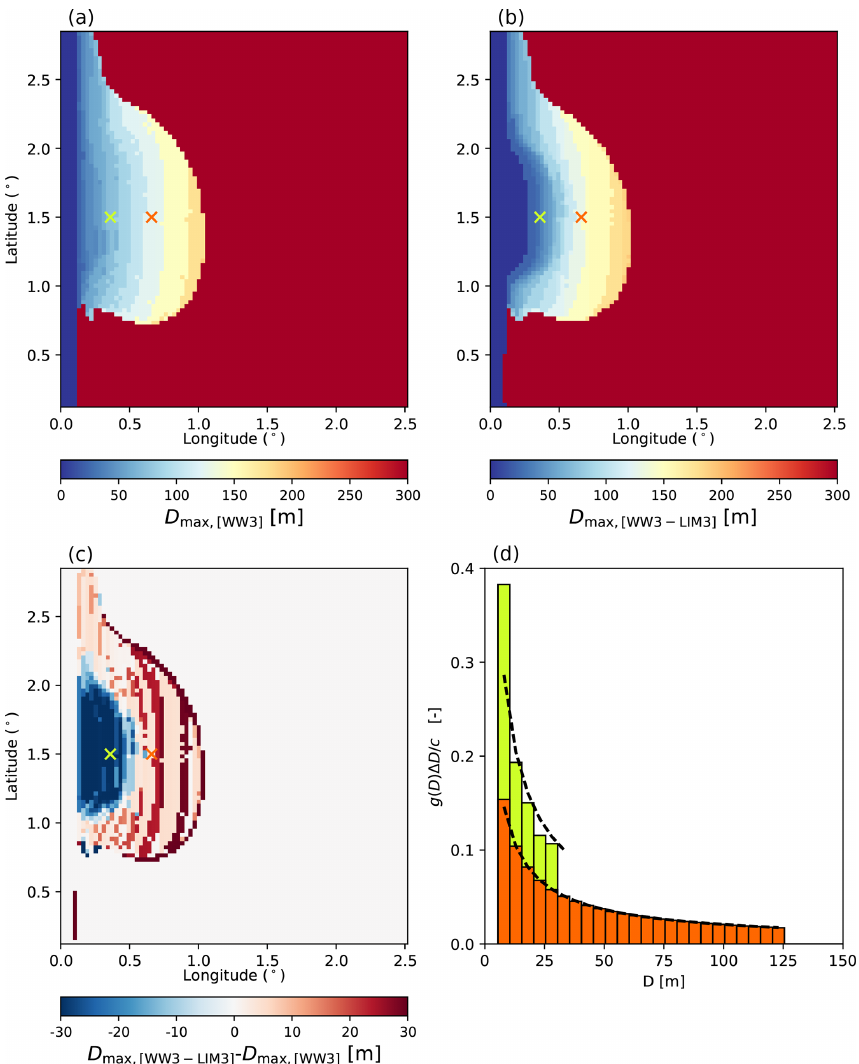
Figure 3. Snapshots of D max from the uncoupled WW3 (a) and the WW3–LIM3 (b) simulations after 72h and the difference between the two (c) . Panel (d) shows the FSD from the WW3–LIM3 run at two locations indicated with crosses on (a–c) . The dashed black line in (d) corresponds to the theoretical power-law FSD assumed in